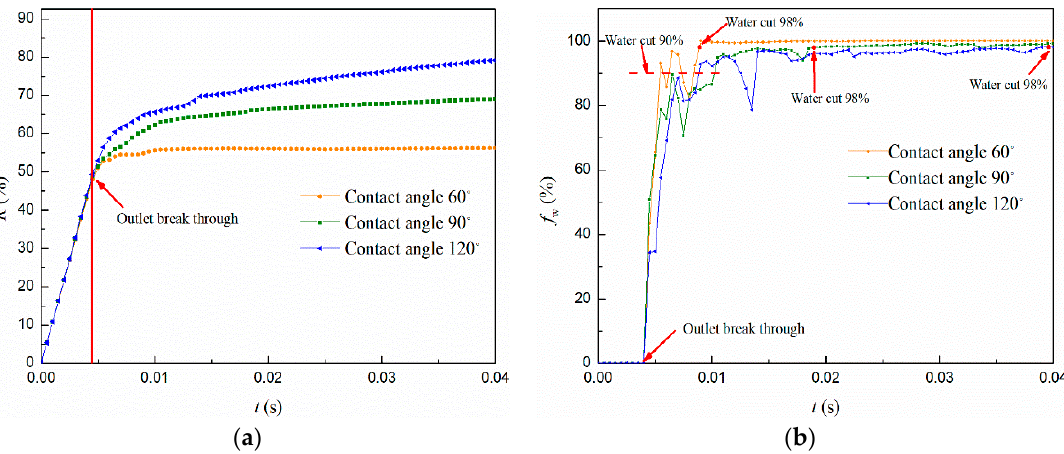
Figure 7. The oil recovery and water cut at the outlet: ( a ) oil recovery rates (Y-axis is oil recovery rate, % and X-axis is time, s) and ( b ) water cut curves (Y-axis is water cut, % and X-axis is time, s).